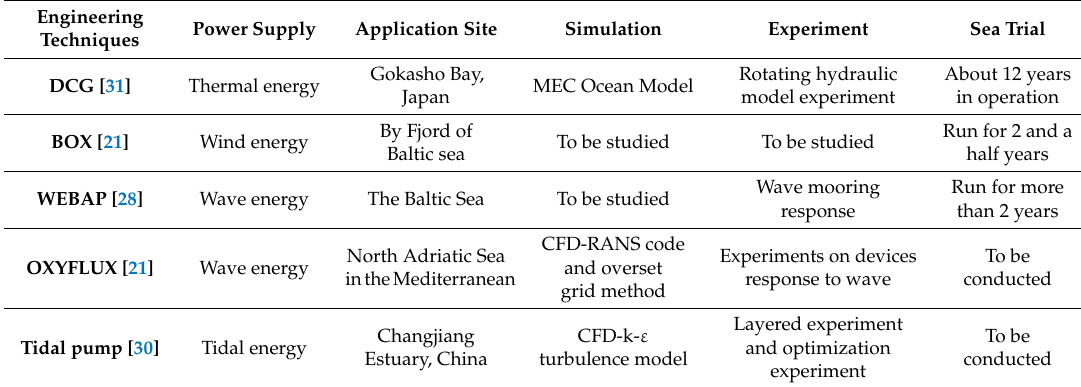
Table 1. Di ff erent types of artificial downwelling